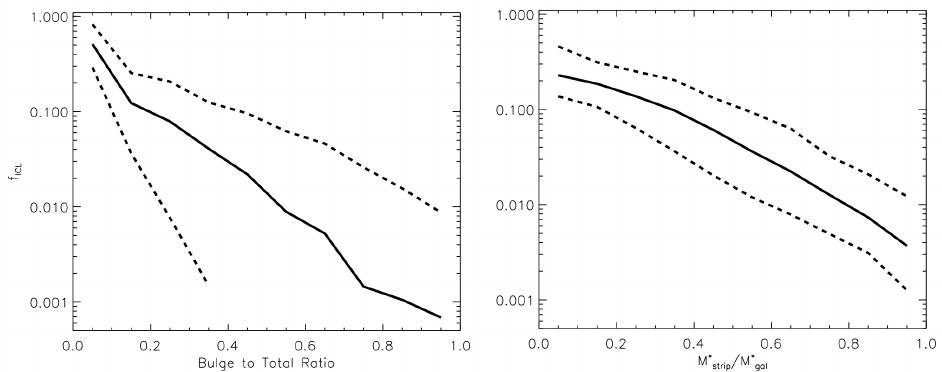
Figure 7. Left panel: fraction of ICL mass via stellar stripping as a function of the bulge-to-total mass ratio of galaxies subject to stripping events, within 100 kpc from the halo center. Right panel: same information as the left panel but as a function of the ratio between the amount of mass stripped and the mass of the satellite at the moment of stripping. In both panels, solid and dashed lines represent the median, the 16th and 84th percentiles of the distributions, respectively. Credit: Contini et al.